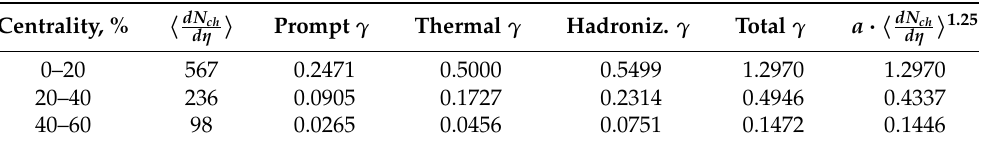
Table 1. The different contributions to the total direct-photon yield in iHKM for the top RHIC energy Au+Au collisions. The data for the three collision centrality classes together with the corresponding (cid:105) are presented. mean charged particle multiplicities (cid:104) dN ch d η (cid:105) Prompt γ Thermal γ Hadroniz. Centrality, % (cid:104) dN ch d η